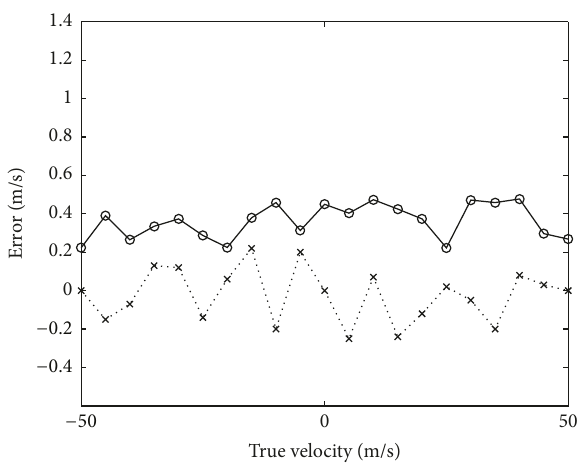
Figure 2: Standard deviation (solid line with hollow dot) and bias (dotted line with cross) of estimated velocities in Figure